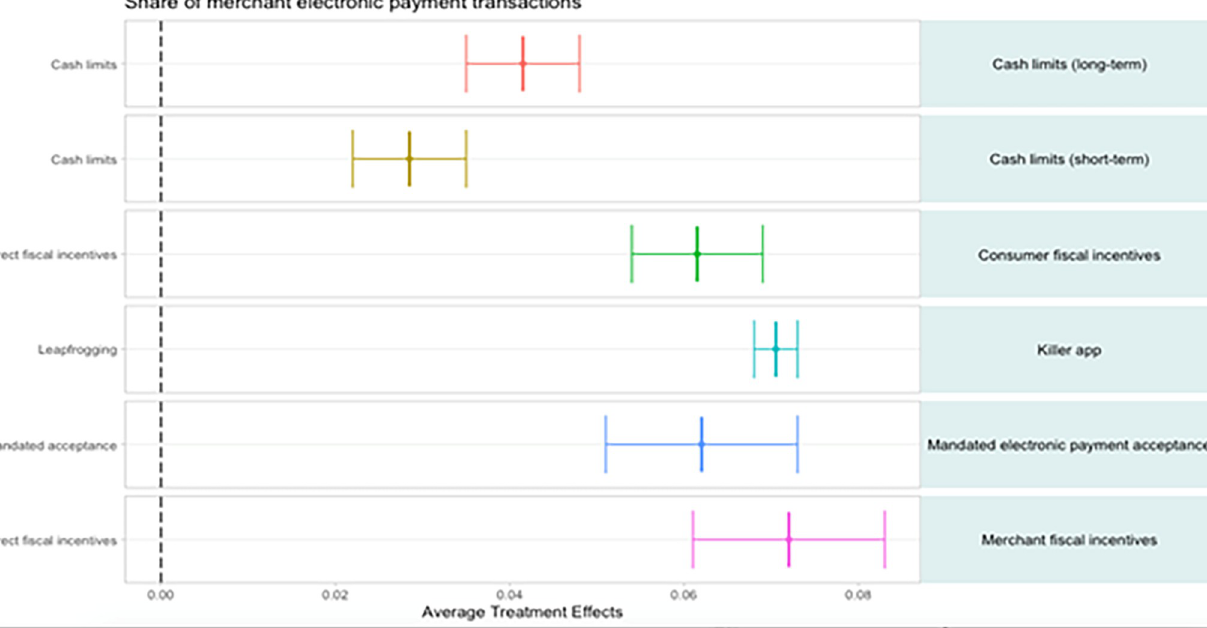
PLOS ONE | https://doi.org/10.1371/journal.pone.0276203 November2,